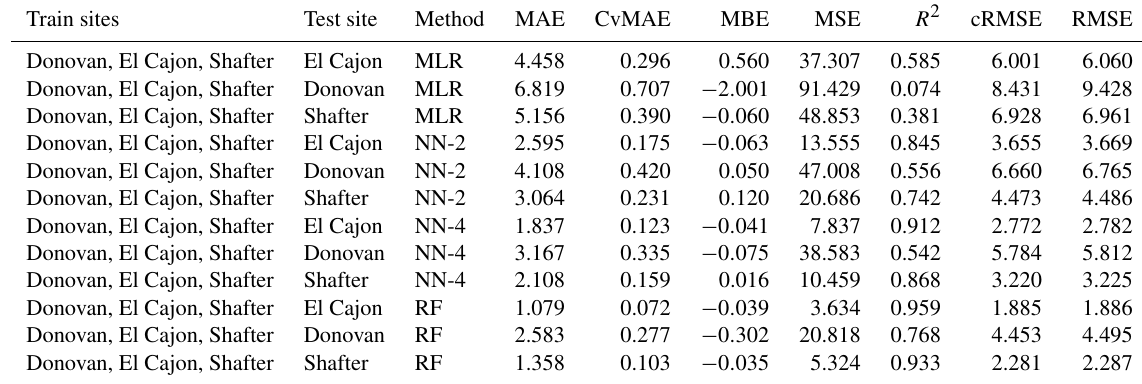
Table C14. Level 3 test results for NO 2 .